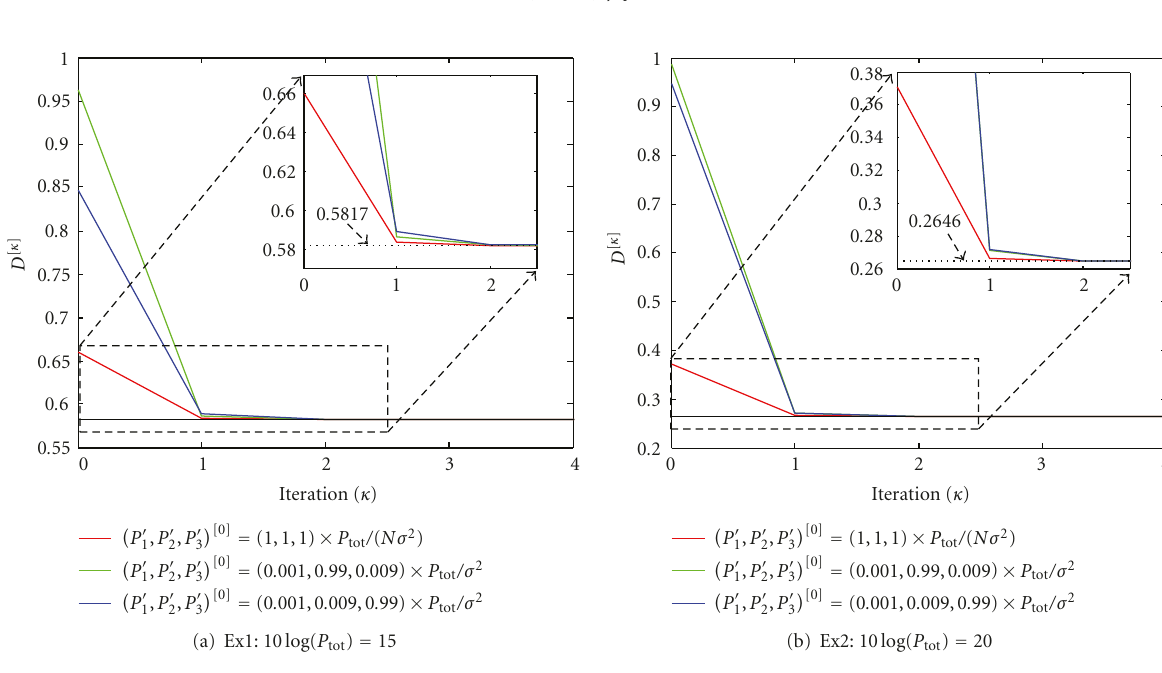
= (0 . 01,1,10) . , h i , σ 2 ) N n i w i i = 1